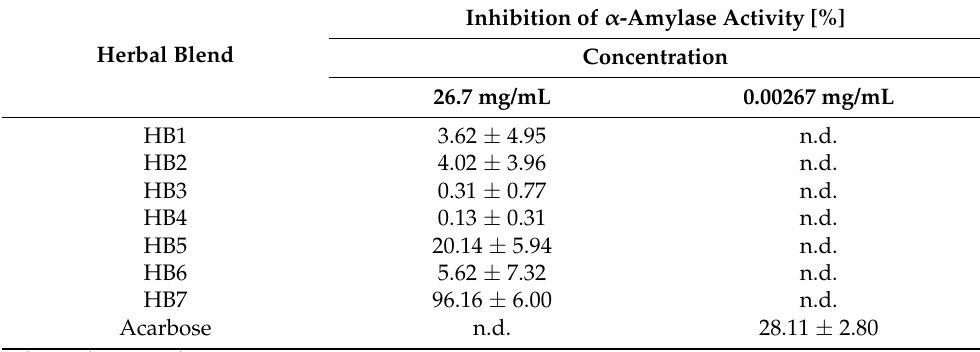
Table 5. Inhibition of α -amylase activity by the infusions from herbal blends.